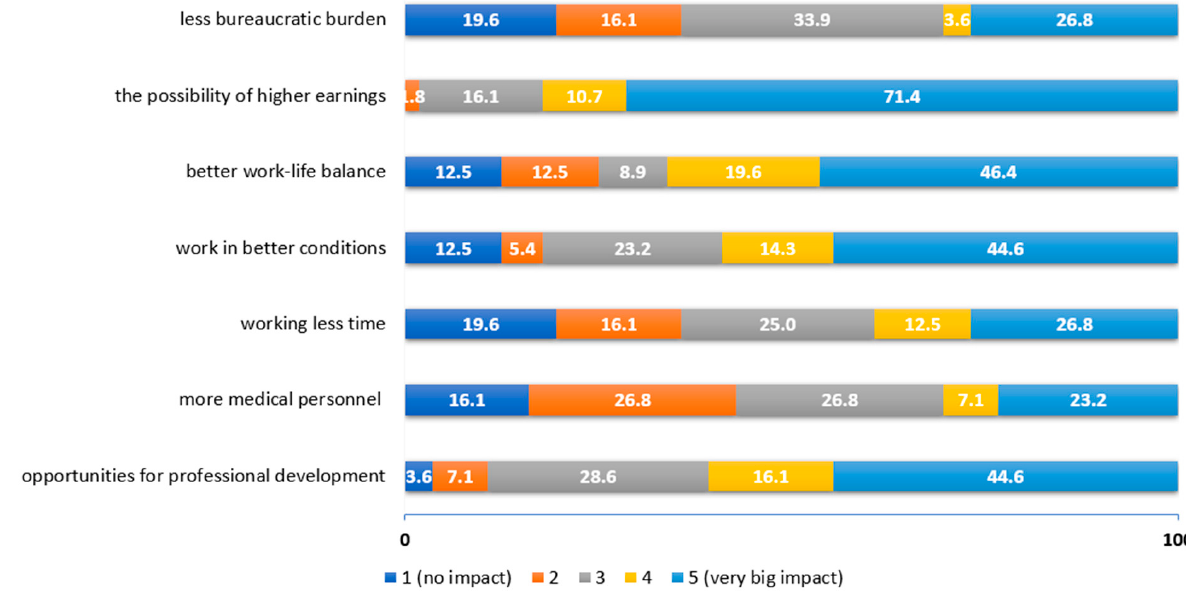
Figure 4. Assessment of the influence of pull factors according to practicing physiotherapists.